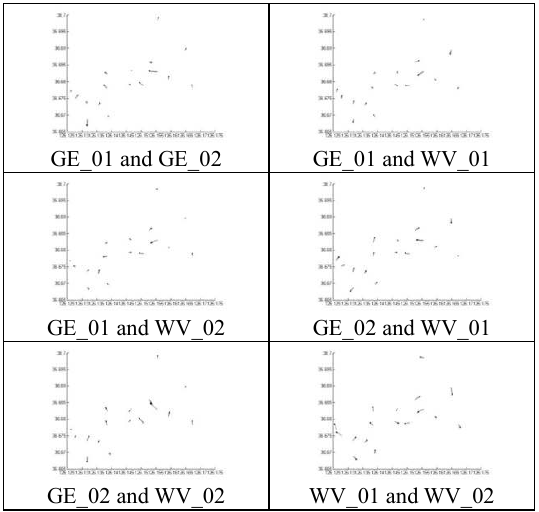
Figure 6. Residuals of stereo models with four GCPs